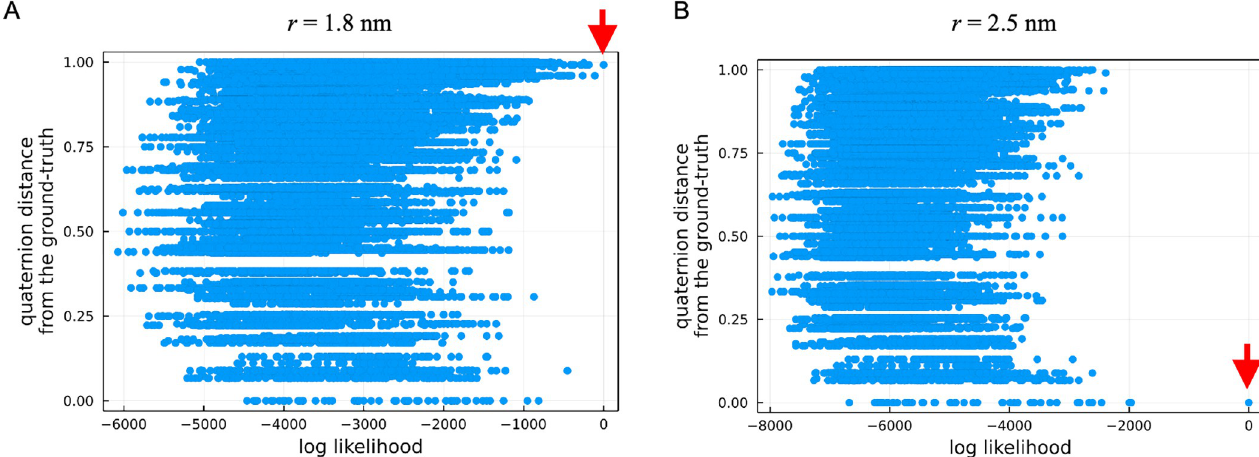
Fig 4. Likelihood distribution over all possible orientations and structures computed using the first single frame of the first set AFM data (defined by Eq 2). Likelihoods are projected onto the quaternion distance from the ground-truth. The maximum likelihoods are indicated by red arrows. (A) Likelihoods computed with the tip apex radius of 1.8 nm. (B) 2.5 nm (the ground-truth tip radius).